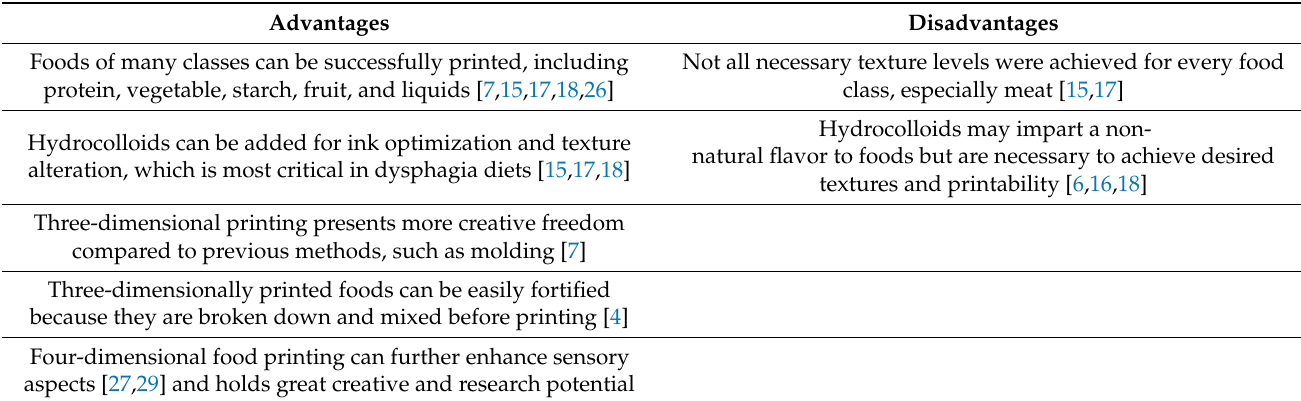
Table 2. Summary table of advantages and disadvantages of 3D food printing for